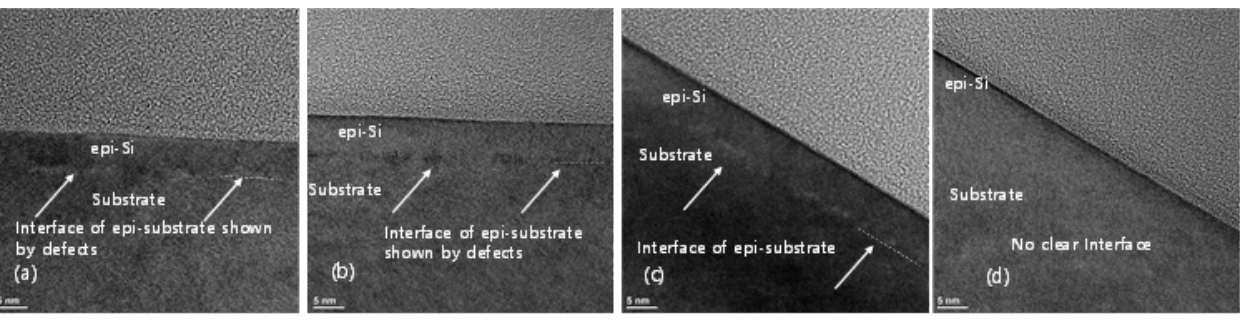
Figure 6. The TEM images of the Si epitaxial films obtained after wet pre-cleaning and subsequent H 2 bake at various temperatures. ( a ) 700 °C for 10 min, ( b – d ) 750, 800, 850 °C for 5 min.